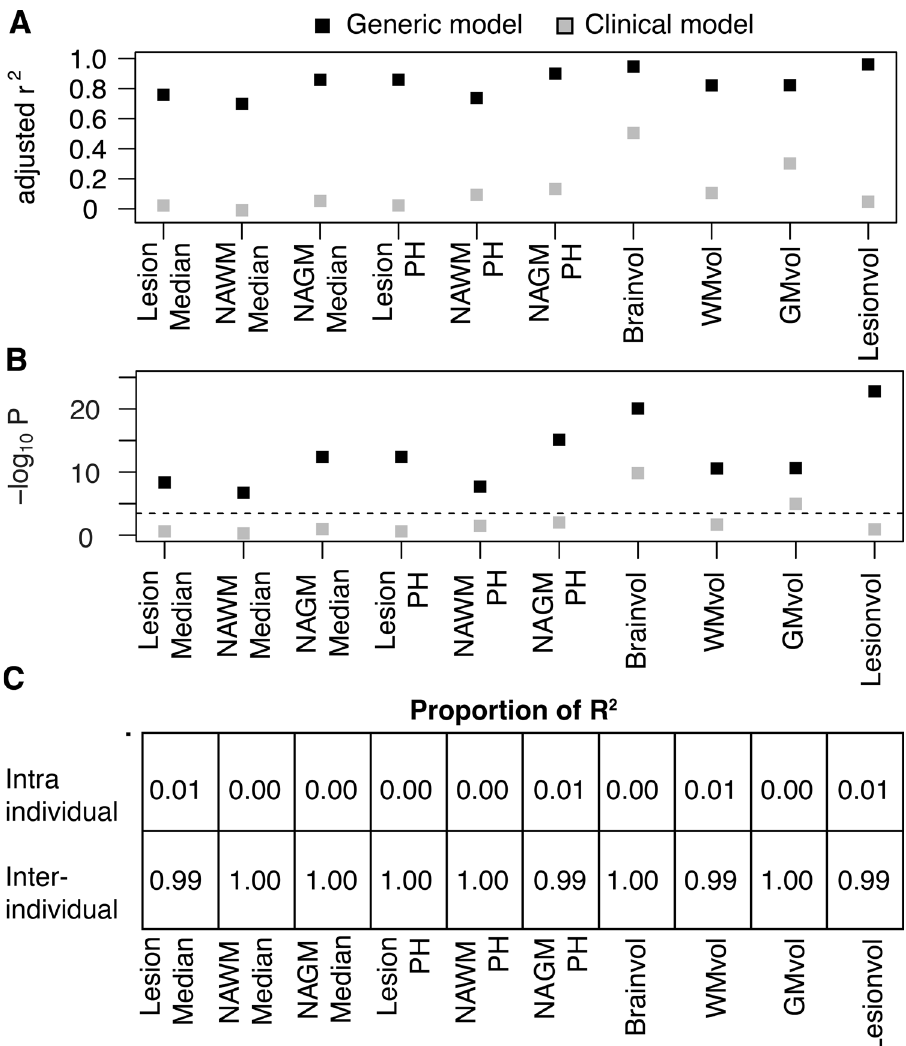
Figure 3. Contribution of inter- and intra-individual variance in longitudinal MRI data. In the longitudinal cohort of 33 patients we visualized the ( A ) percentage of variance explained (= adjusted r 2 ) and ( B ) significance in a generic model (black) including a unique patient identifier code (i.e. inter-individual variation) and time (i.e. intra-individual variation) and a clinical model (grey) including gender, age, disease duration (i.e. known variables of inter-individual variation) and time. The dotted line represents the cut-off for significance of P ≤ 0.05 after correction for multiple testing (P ≤ 0.0025). ( C ) The relative contributions of inter-individual and intra- individual variation over time to the total variance explained in the generic model. PH peak height, NAWM normal appearing white matter, NAGM normal appearing grey matter, WM white matter, GM grey matter, vol volume (Image generated with Rv3.6.1, https ://www.R-proje